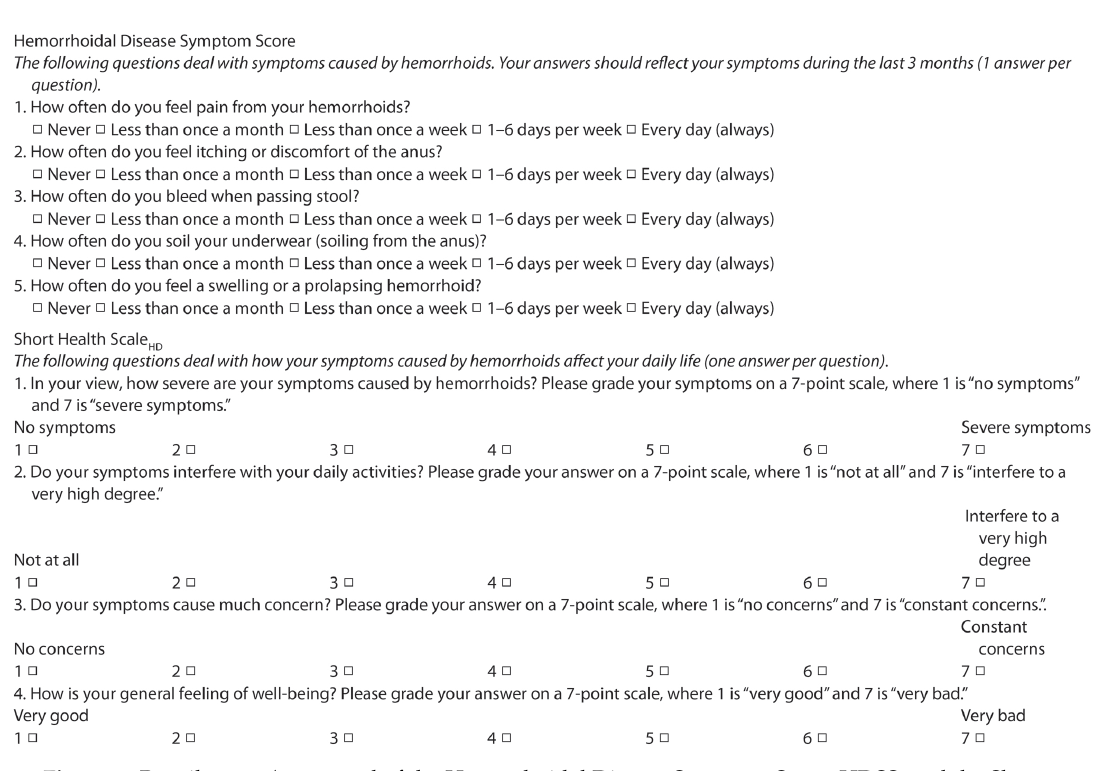
Figure 1. Rørvik score (composed of the Hemorrhoidal Disease Symptom Score, HDSS, and the Short Health Scale-Hemorrhoidal Disease,